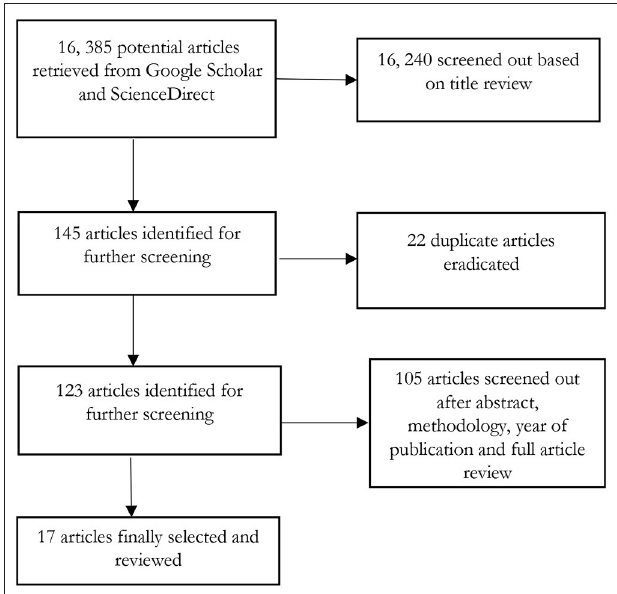
FIGURE 2 | Flow chart of article screening and selection